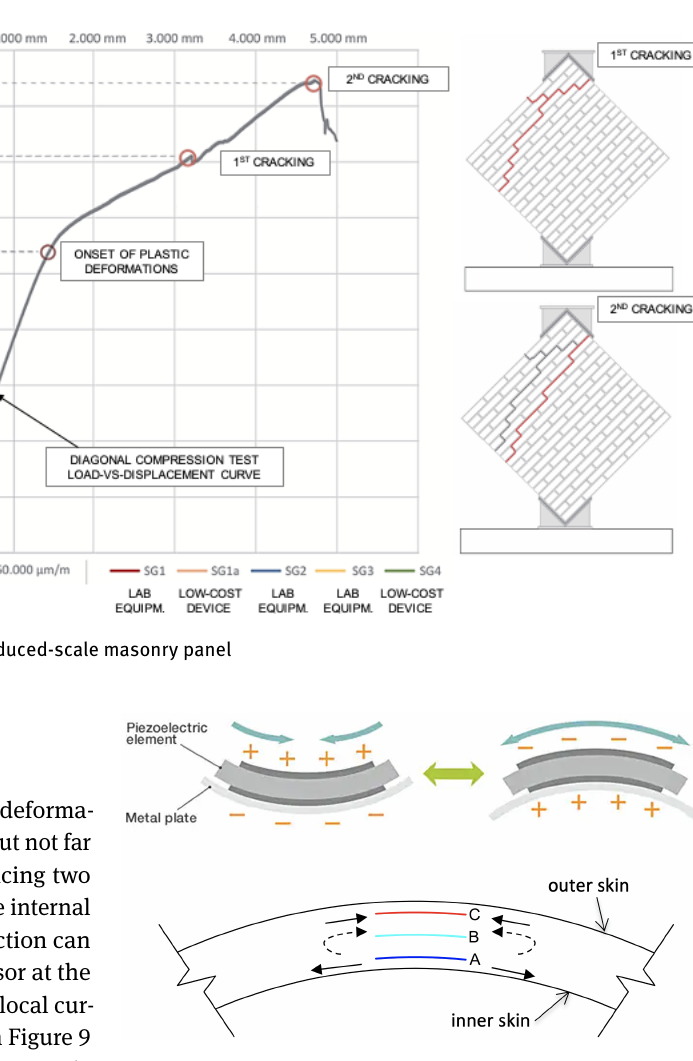
Figure 9: Top: piezo actuator (PiezoHapt TM , TDK courtesy). Bot- tom: cross section of concrete thin shell. A and C are deformation sensors measuring the local in-plane normal stress; B is a sensor measuring the local curvature of the thin shell